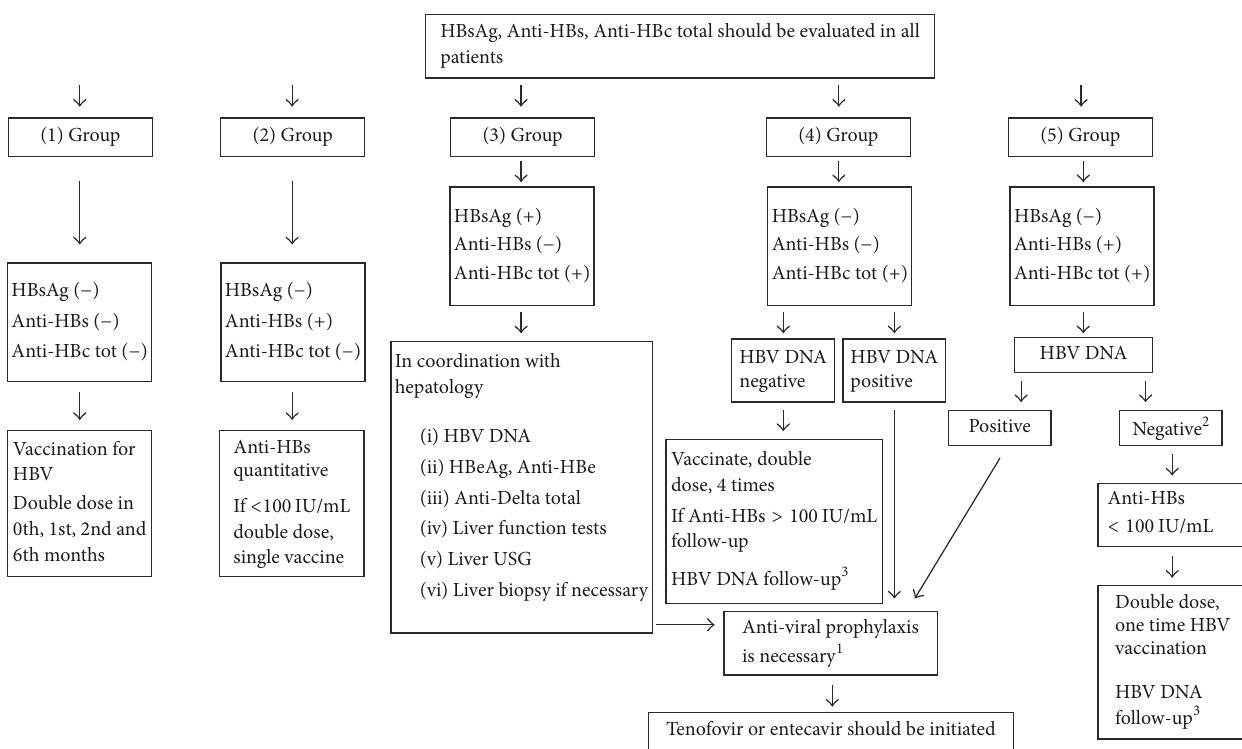
Figure 1: Recommendations for HBV screening and prophylaxis in patients to be administered with bDMARDs, tsDMARDs, or > 7.5mg/day prednisolone [29]. 1 Treatment period is up until the patient becomes HBsAg negative in patients with chronic hepatitis B (liver disease), and antiviral treatment should continue 6–12 months after immunosuppressive and/or bDMARD treatment is completed in patients without liver disease (12 months for rituximab). 2 If rituximab is to be administered, antiviral prophylaxis should be given, even if patients are negative for HBV DNA ( − ). 3 HBV DNA is repeated once in 1–6 months (3 months on average). Figure reproduced with permission from the European Journal of